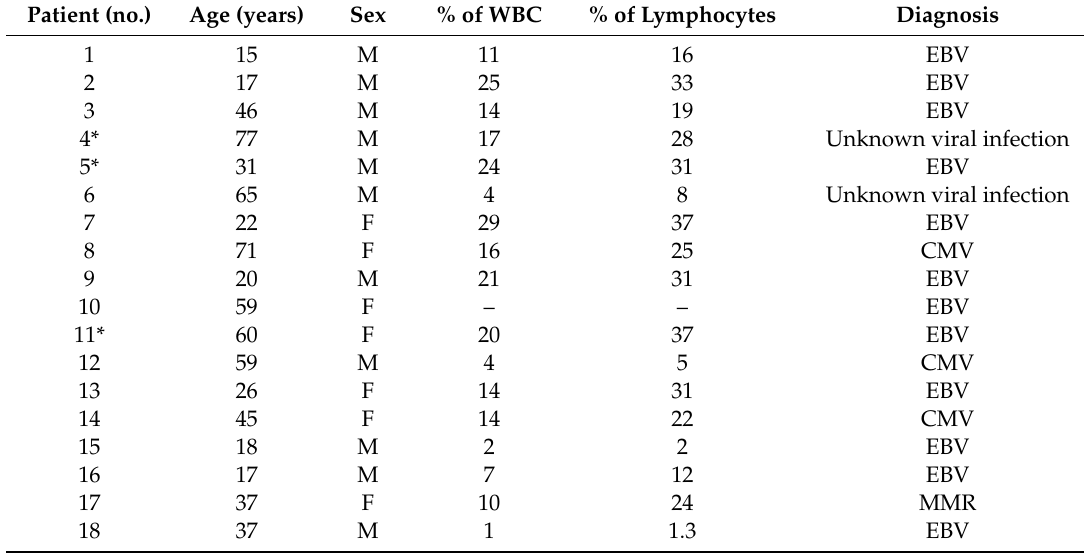
Table 1. Patient